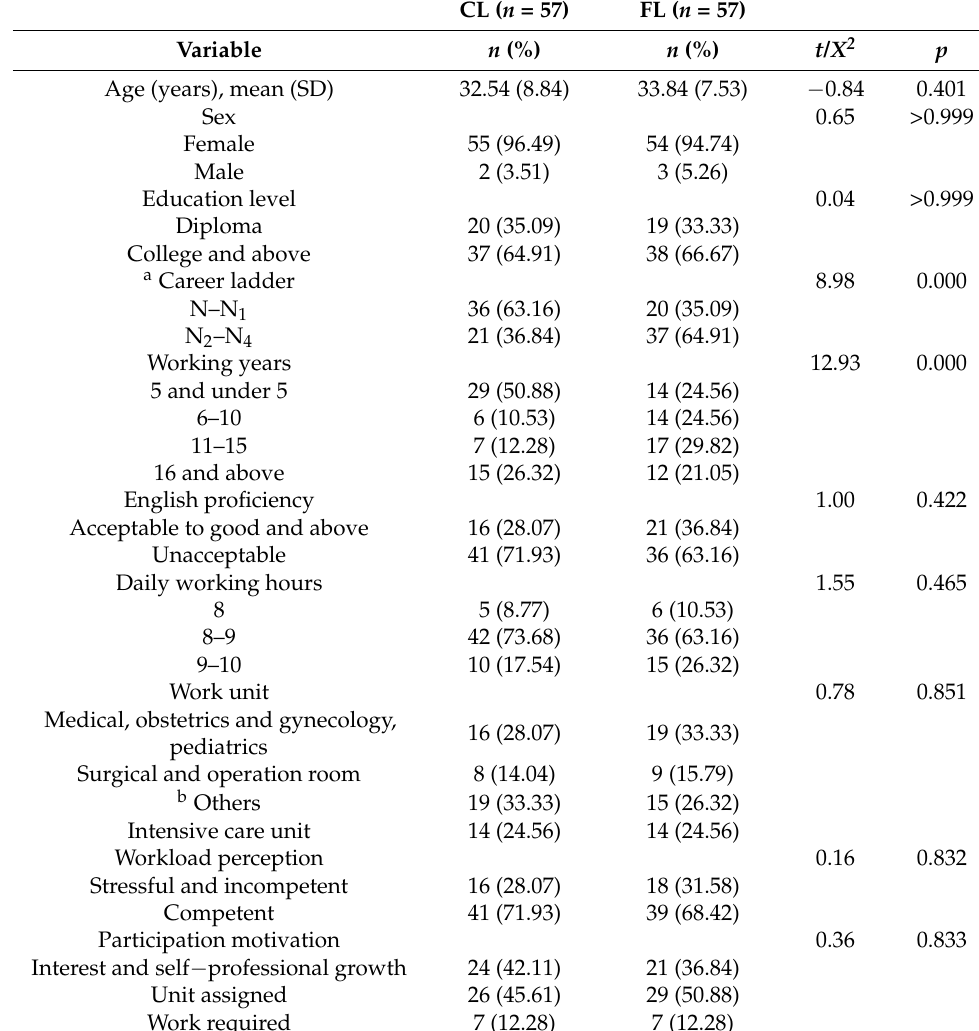
Table 1. Demographic data (N =